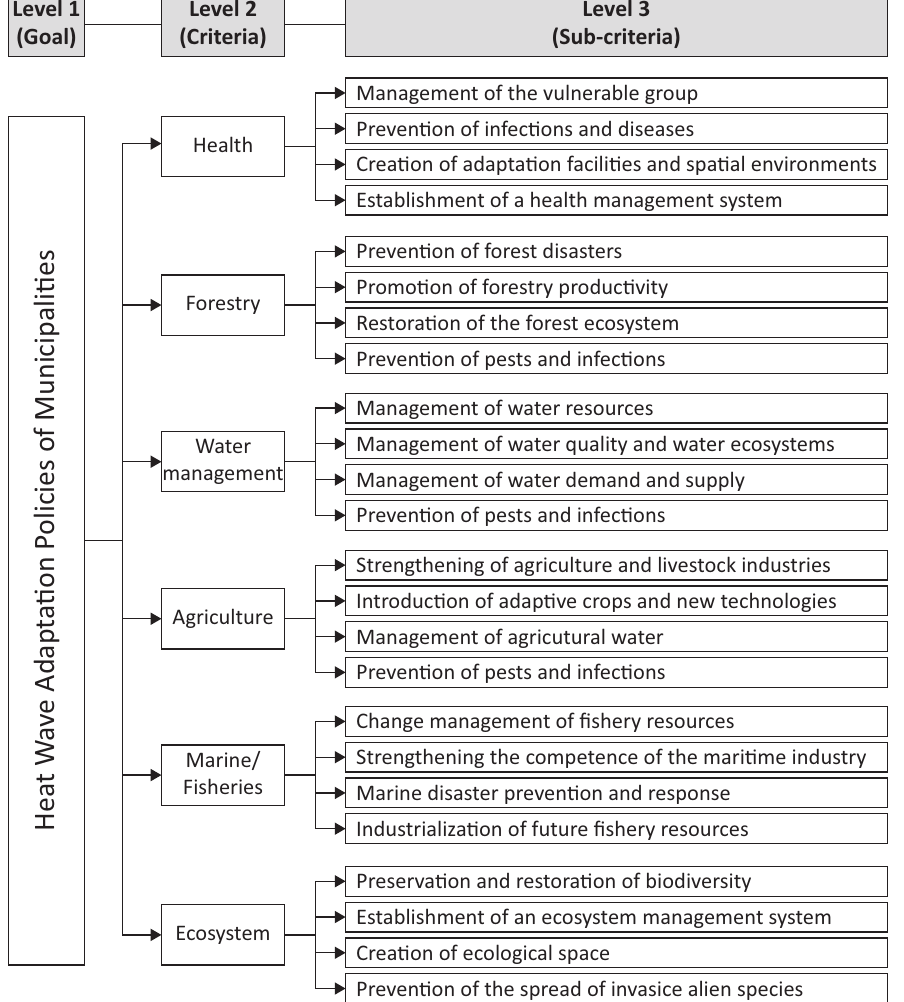
Figure 2. The sectors and response areas of heat wave policy. by van Laarhoven and Pedrycz (1983), has often been applied. The fuzzy AHP analysis method is different from the conventional AHP method in that the data used in the computation process are not normal numbers but fuzzy numbers. A fuzzy number is a value converted from the result of a pairwise comparison in order to deal with the uncertainty and ambiguity inherent in human